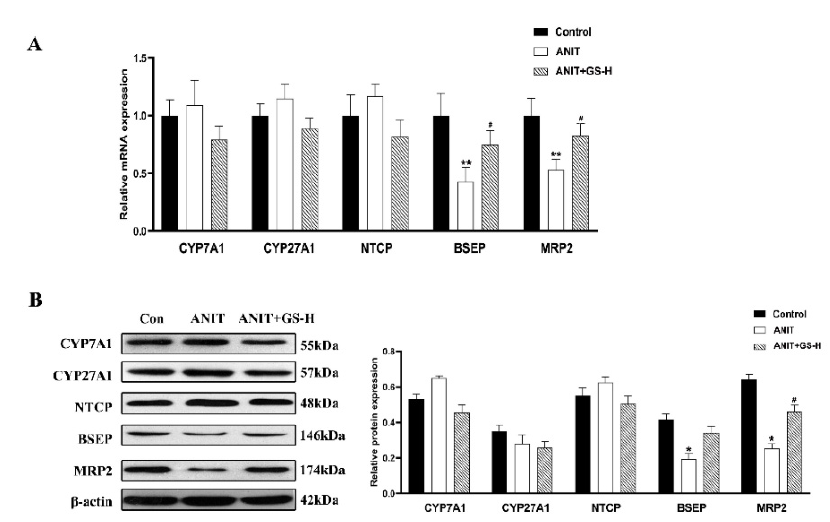
Figure 3. GS treatment improved expression of genes involved in bile acid homeostasis in the liver. ( A , B ) The mRNA levels and protein levels of bile metabolism-related genes (CYP7A1, CYP27A1, NTCP, BSEP, MRP2) in mice after ANIT and GS exposure. Significantly different from control, * p < 0.05 or ** p < 0.01, or ANIT, # p < 0.05.